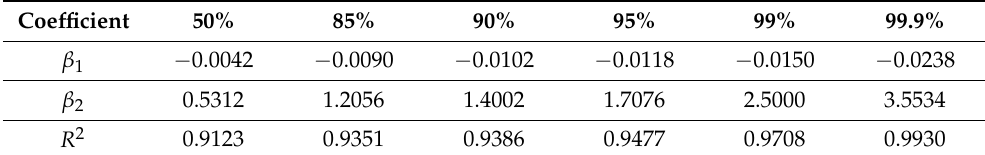
Table 3. The linear fit result of the acceleration.